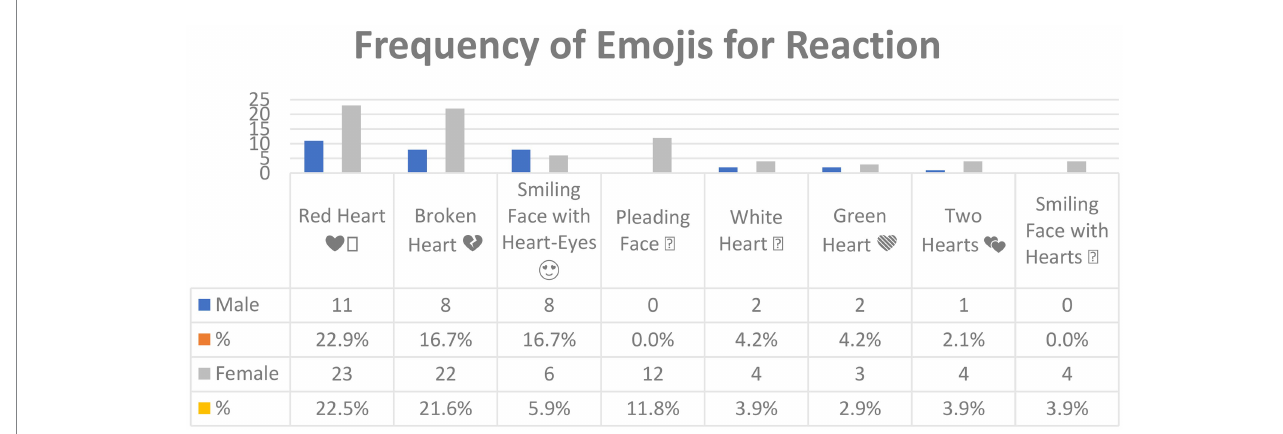
FIGURE 5 The most common emojis used for Reaction in Arabic tweets.